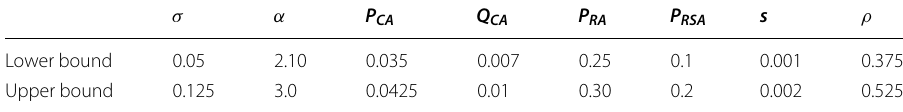
Table 4 Parameter bounds used during the stochastic simultaneous optimistic optimization